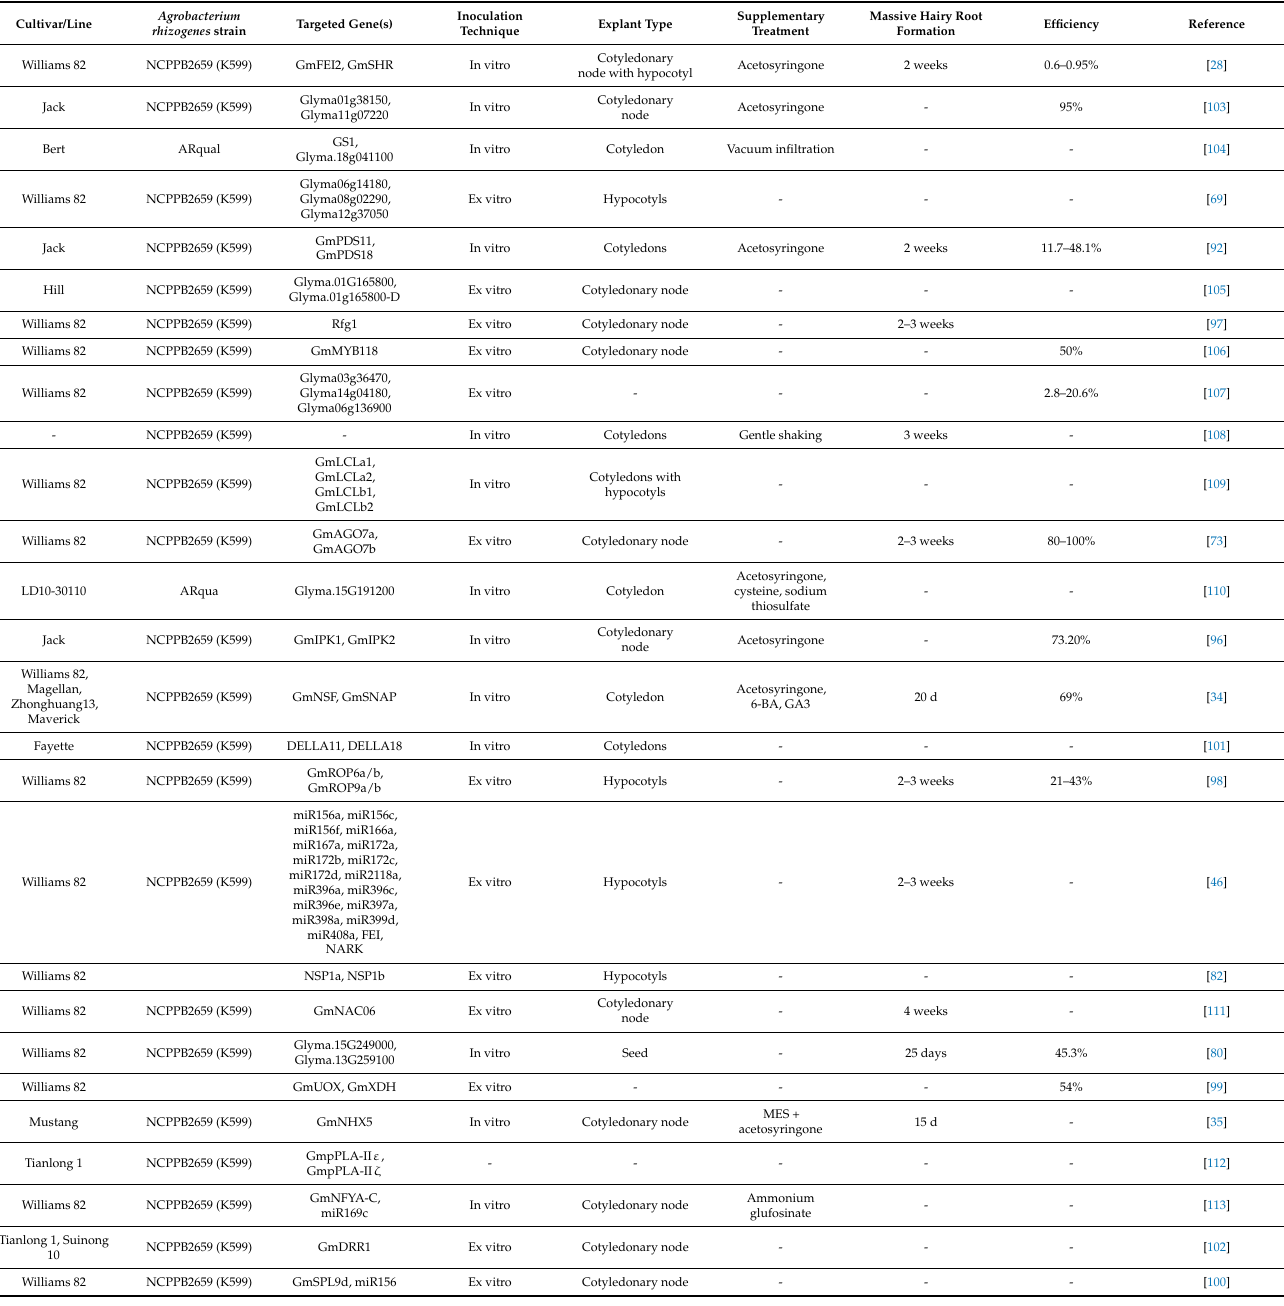
Table 1. Examples of CRISPR/Cas9-based A. rhizogenes -mediated hairy root transformation for functional analysis of different genes in soybean